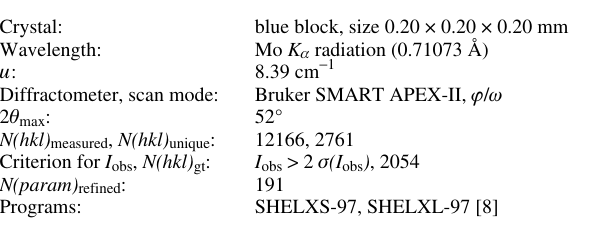
Table 1. Data collection and